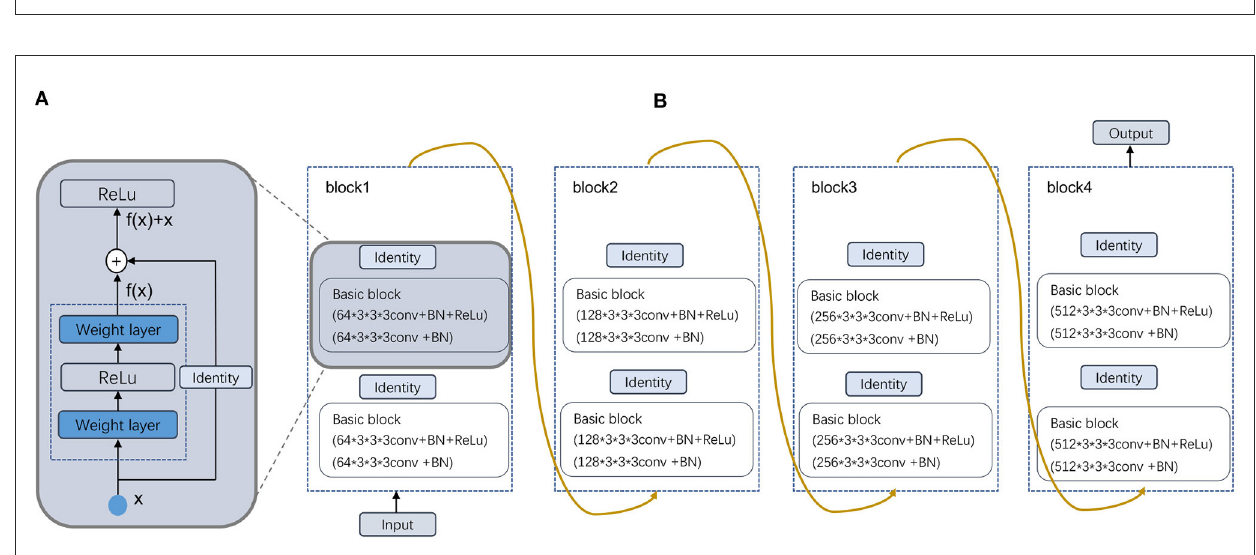
FIGURE1 The overview of multimodal fusion containing T1WI, T2WI, FLAIR, and ADC images as input.